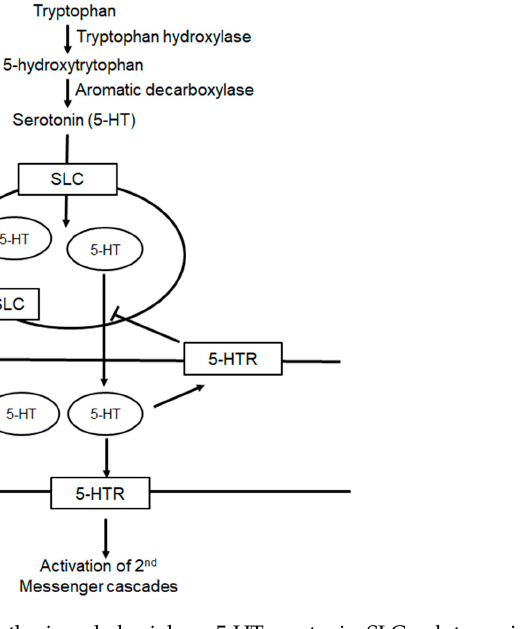
Figure 2. 5-HT biosynthesis and physiology. 5-HT: serotonin; SLC: solute carrier; 5-HTR; serotonin receptor. Polymorphisms in the 5-HTR2A (5-hydroxytryptamine receptor 2A) gene have been associated with FM and depressive symptoms. FM female individuals carrying the 5- HTR2A polymorphism of Cytosine-Thymine (CT) genotype have lower pain thresholds than those with TT and CC genotypes [41]. FM individuals with a combined 5-HT1a CC and 5-HTT -high expression have the fewest depressive symptoms compared to individu- als with a combined 5-HT1a CC/G and 5-HTT -low expression [53]. SNP rs1062613 with the CC homozygotes genotype in the 5-HTR3a gene were found to be more frequent in individuals with FM than in healthy controls. Carriers of the CC genotype were found to have fewer dopamine receptors available when compared to TT carriers, suggesting that CC carriers may experience less reward associated with dopa- mine release. However, there was no association between rs1062613 and pain threshold or tolerance [54,55]. Further examination of six di ff erent 5-HTR3a variants and eight dif- ferent 5-HTR3b variants revealed mixed results when compared to healthy controls [55]. Several variants were more frequently observed in individuals with fi bromyalgia com- pared to healthy controls but did not reach statistical signi fi cance.